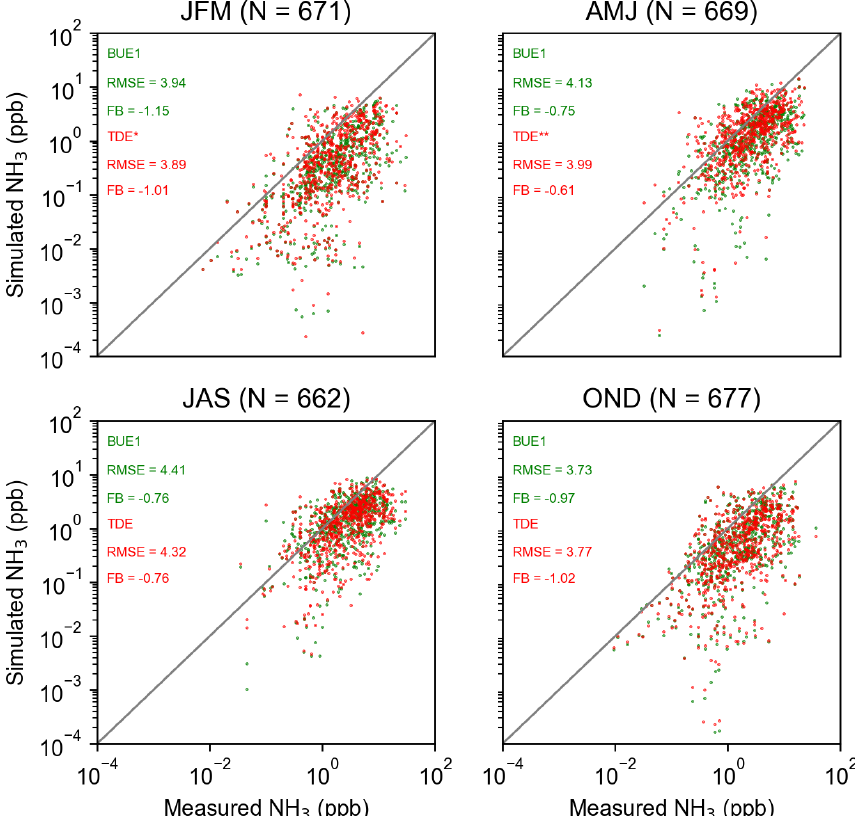
Figure 8. Validation of simulated NH 3 concentrations driven by BUE1 and TDE against ground-based measurements from AMoN, emep, and EANET for selected years (2008, 2013, and 2018) in four seasons (January–March, JFM; April–June, AMJ; July–September, JAS; and October–December, OND). Scatterplots are plotted using a log scale, and the average RMSE (ppb) and FB (%) for each season are inset. The asterisk symbols “*” and “**” represent that differences between BUE1 and TDE are significant at the 95% and 99% confidence levels,